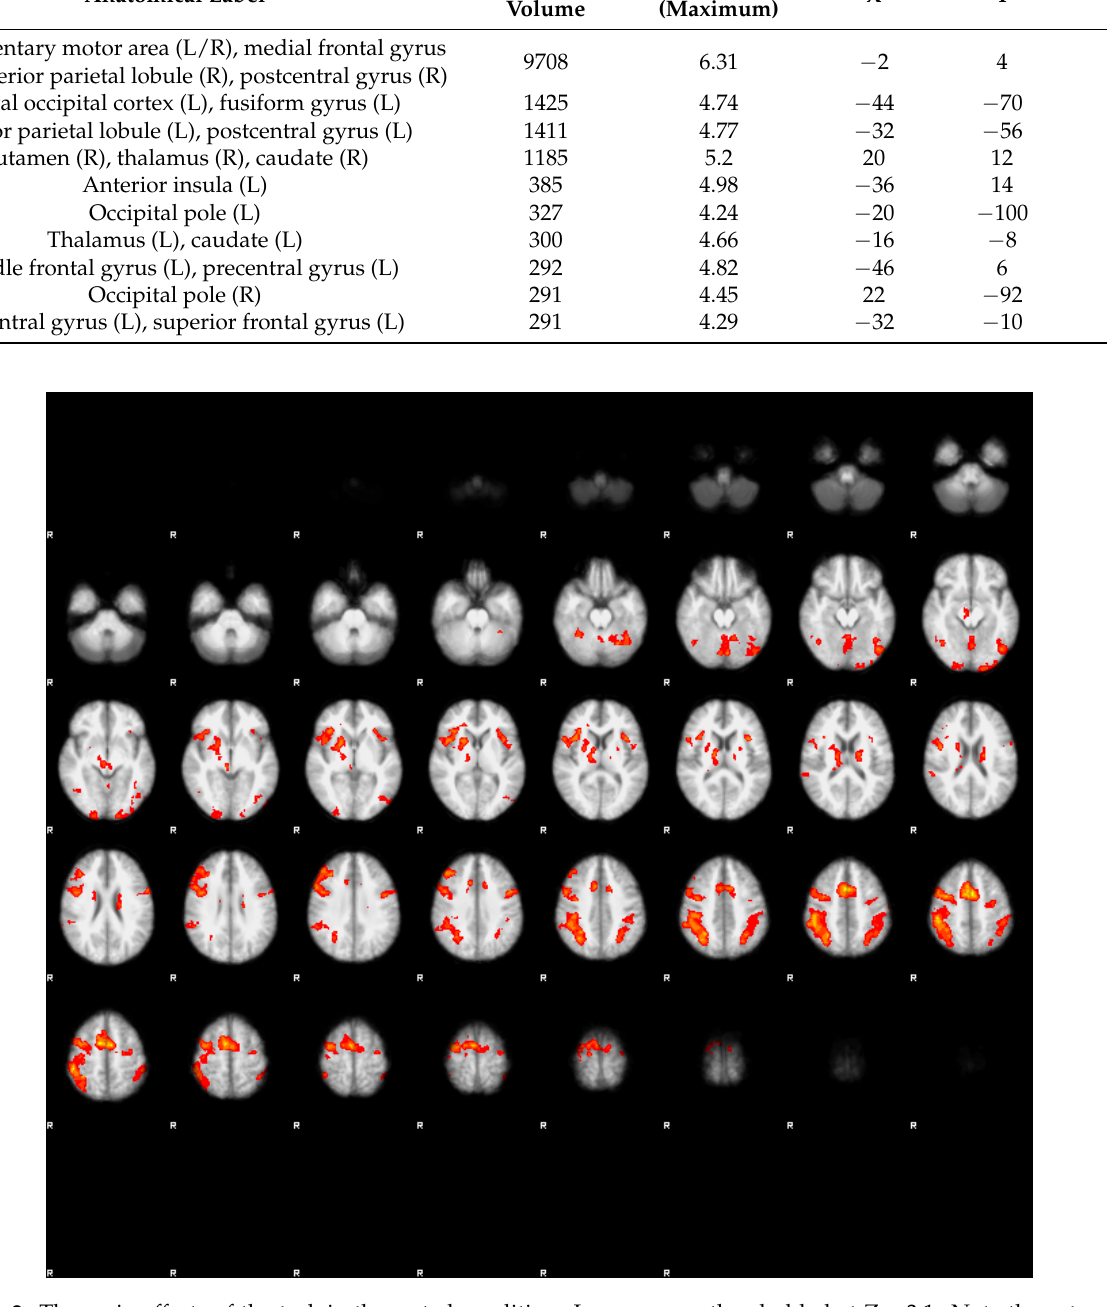
Figure 2. The main effects of the task in the rested condition. Images were thresholded at Z > 3.1. Note the extensive bilateral activation in the posterior parietal cortices, SMA, premotor cortex, and dorso-lateral prefrontal cortex. Activation in the middle temporal cortex was left-lateralized. The right side of the brain is denoted by letter R. Table 3. Main effects—rested condition. The table lists the approximate anatomical details of the suprathreshold clusters. Z-score represents the maximum Z value within the given cluster. X, Y, and Z values denote MNI coordinates of the maximum Z-value voxel. Cluster volume is given as a voxel count. Anatomical labels were identified using the Harvard-Oxford Cortical and Subcortical At- lases, Juelich Histological Atlas, and Talairach Daemon Labels as provided by FSL software (https://fsl.fmrib.ox.ac.uk/fsl/fslwiki/Atlases (accessed on 20 August 2021)). The characters within parentheses accompanying the anatomical labels indicate the hemisphere—left or right. Anatomical Label